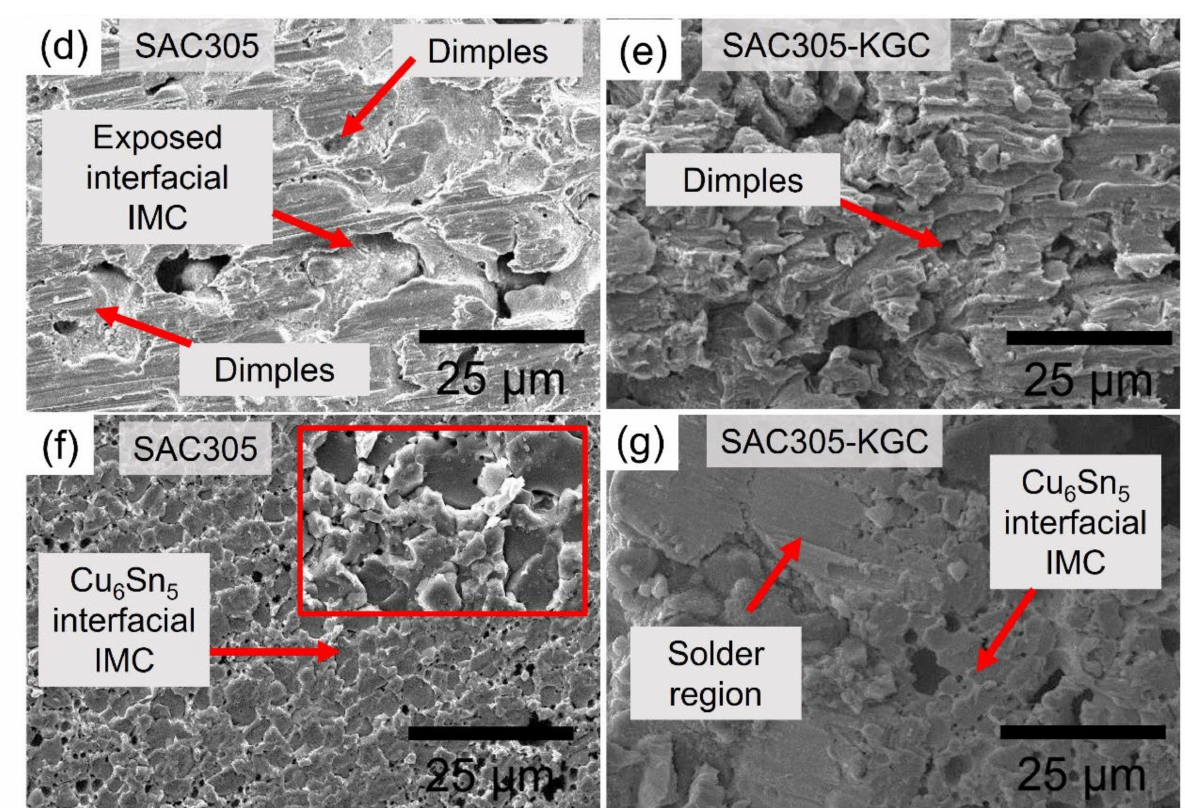
Figure 13. ( a ) Shear strength of SAC305 and SAC305-KGC subjected to multiple cycles of reflow soldering. SEM fracture surface of ( b ) SAC305 at 1st reflow, ( c ) SAC305-KGC at 1st reflow, ( d ) SAC305 at 3rd reflow, ( e ) SAC305-KGC at 3rd reflow, ( f ) SAC305 at 6th reflow, and ( g ) SAC305-KGC at 6th reflow